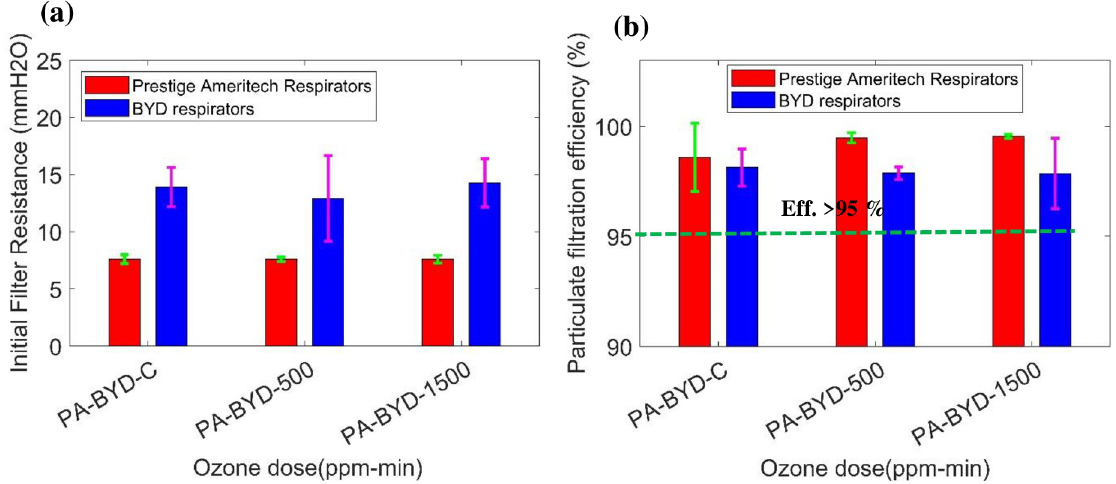
Fig 21. (a) Initial filter resistance and (b) particulate filtration efficiency of Prestige Ameritech and BYD respirators (control samples and 1 (500 ppm-min) and 3 (1500 ppm-min) decontaminated cycle of plasma